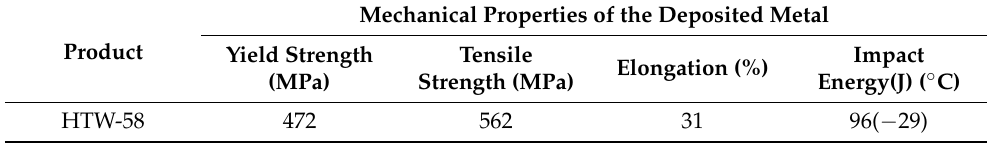
Table 5. Chemical composition of the deposited metal.